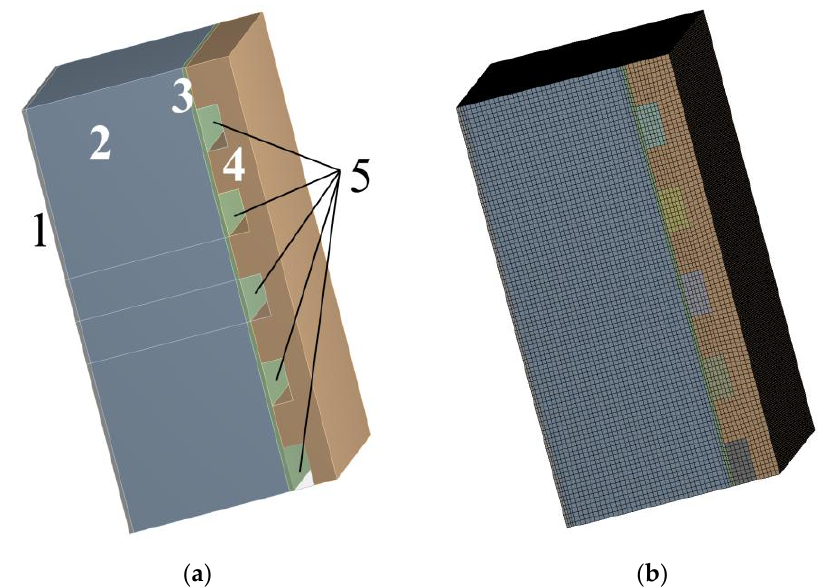
Figure 9. The enclosure section according to Figures 5 and 6: ( a ) sketch: 1, 3 — cement-sand plaster; 2 — bearing layer from ceramic brick; 4, — insulant from extruded polystyrene foam; 5 — horizontal closed air gap; ( b ) finite element model.